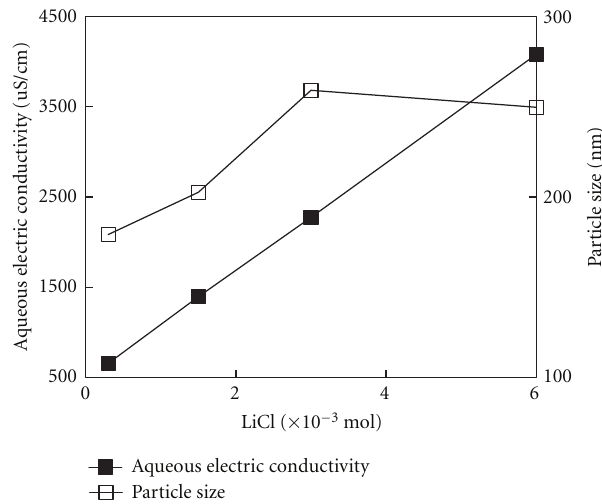
Figure 5: Aqueous electrical conductivity and average particle size at di ff erent lithium ion concentrations (copper ion concentration is held constant at 0.3 × 10 − 3 mol).